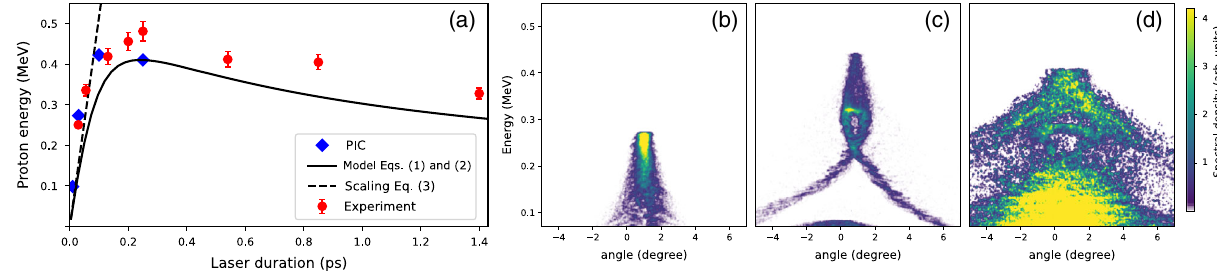
FIG. 3. (a) Maximum proton energy as a function of laser pulse duration obtained experimentally (red dots), in PIC simulations (blue diamonds), from numerical integration of proton motion with Eq. (1) and (2) (black solid line), and the scaling Eq. (3) (dashed line). (b – d) Final angular spectral distributions of protons for 30 fs (b), 100 fs (c) and 250 fs (d) laser pulse